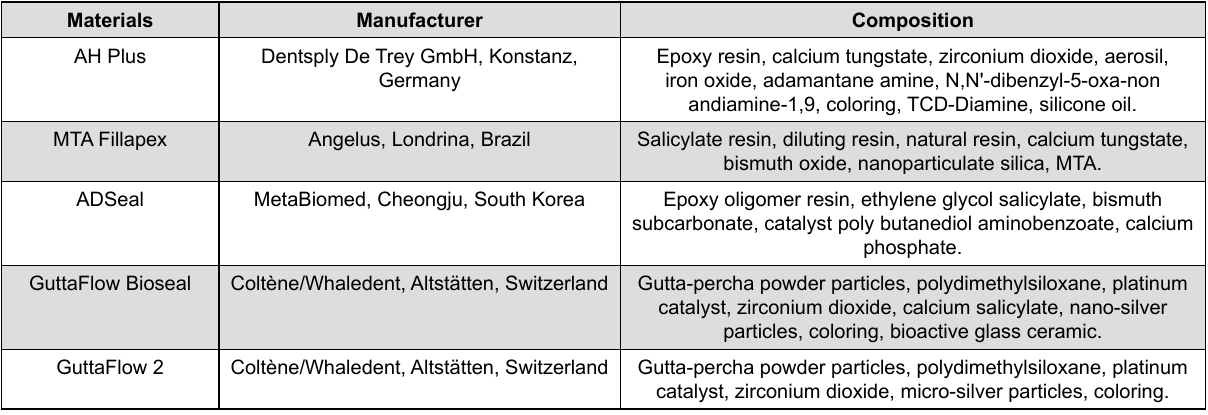
Figure 1- Composition of root canal sealers and their